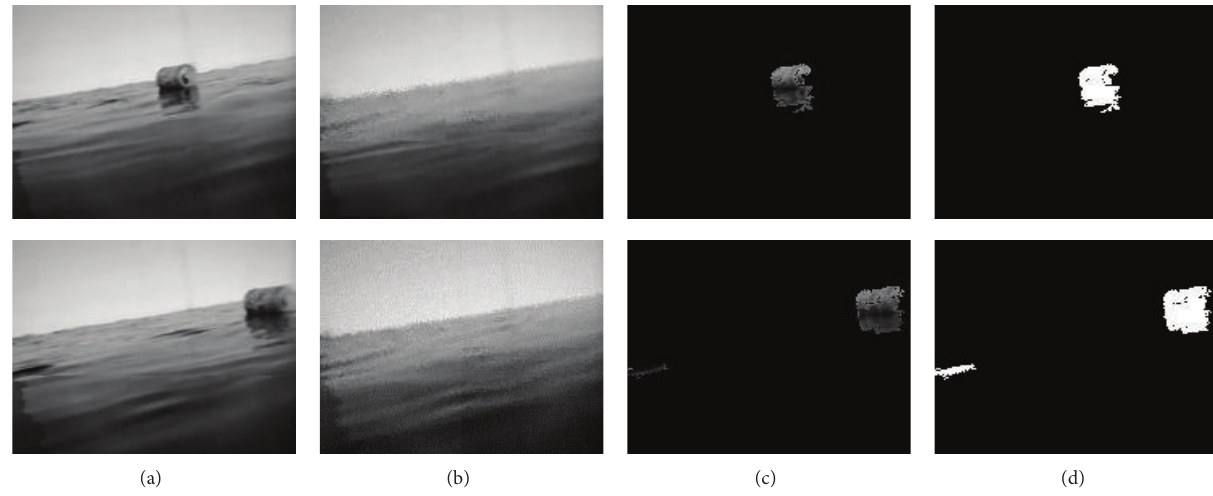
Figure 1: Results on a video sequence of 150 frames with background disturbances. (a) Original frames, (b) background, (c) background subtracted images, and (d) foreground